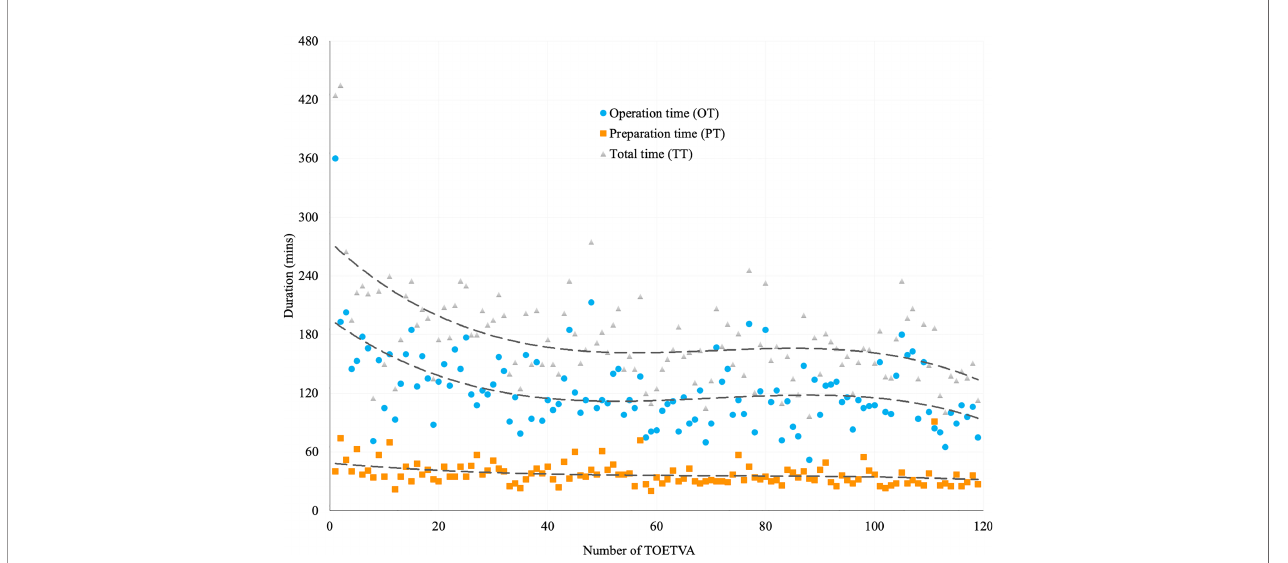
FIGURE 1 | Trend lines for the duration of TOETVA using power cubic equation method. Duration of total time (TT, in gray triangles), preparation time (PT, in orange squares), and operation time (OT, in blue dots) in 119 patients receiving TOETVA.